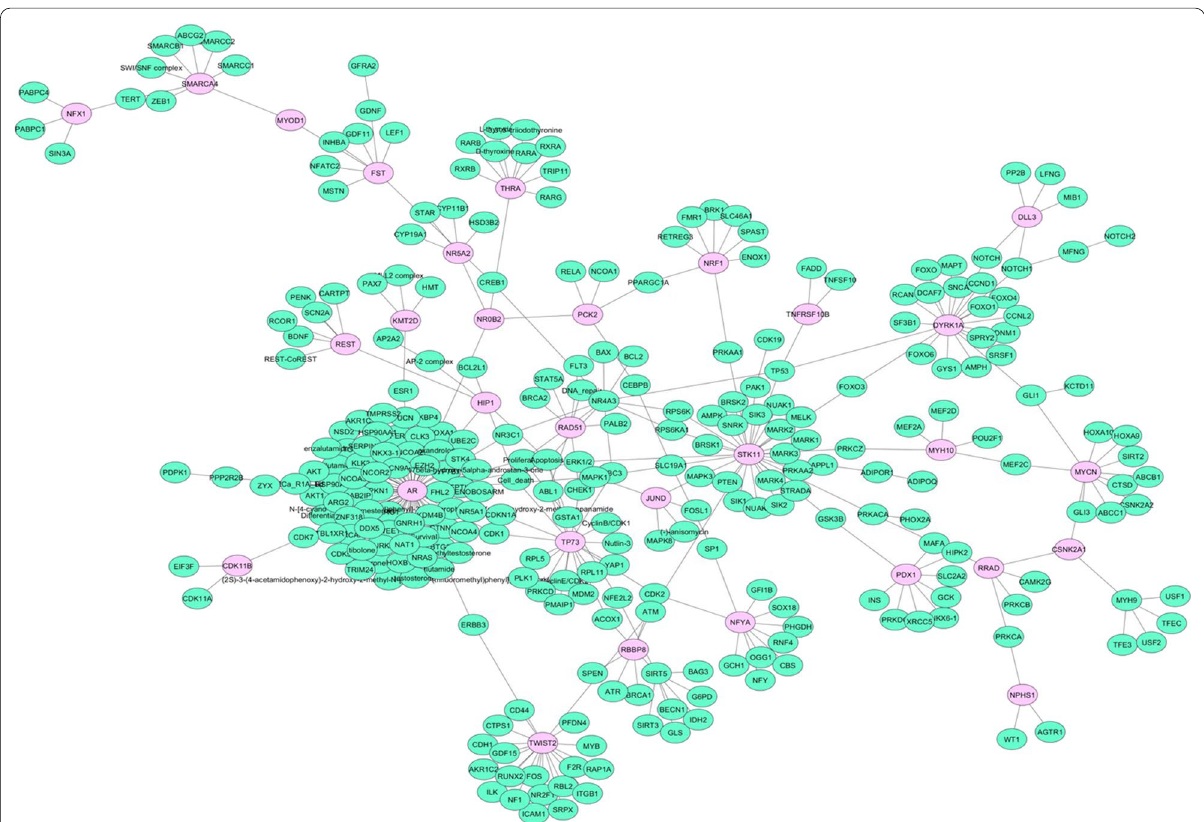
Fig. 4 Extended interactome of gene interaction network from DEGs in a PCOS women with risk of T2DM. Seed proteins in network are highlighted in orange color and corresponding nodes connected with seed proteins in green